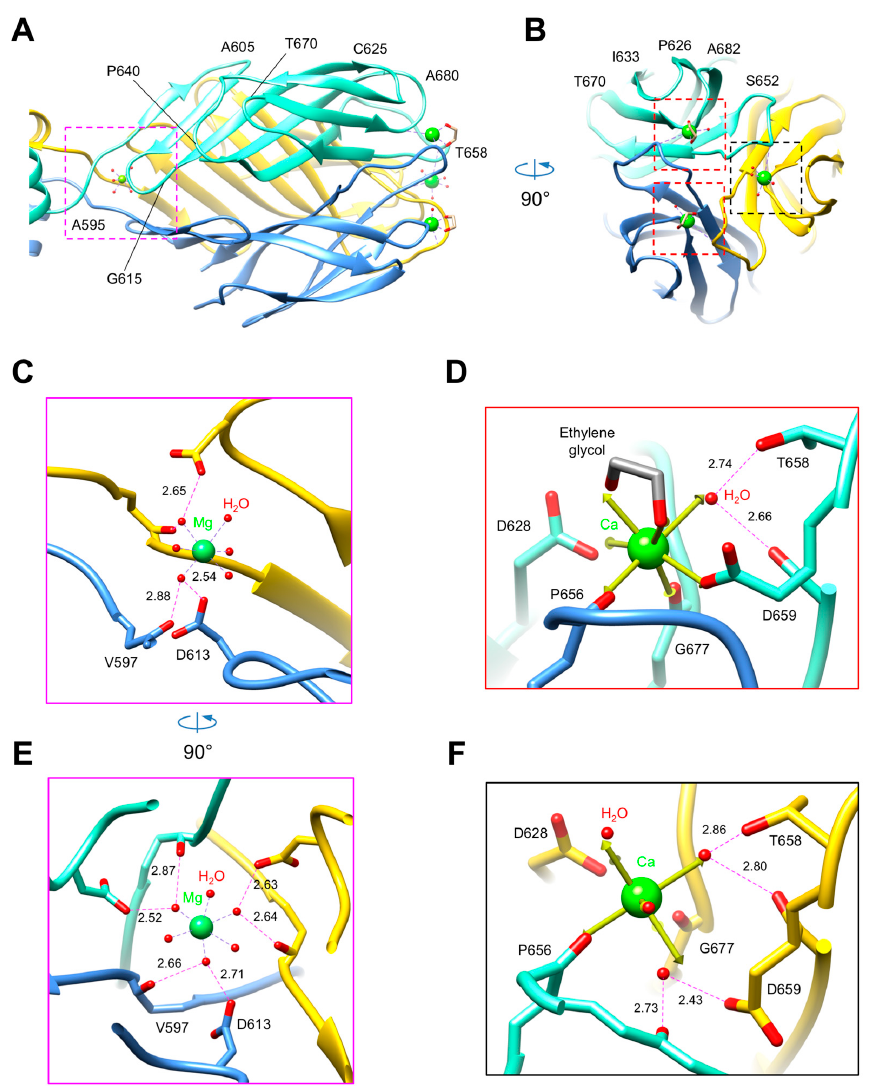
Figure 3. Structure of the R2 fiber C-terminal domain with bound metal ions and ligands. Side view ( A ) and C-to-N end-on view ( B ) of the R2 pyocin receptor binding domain. Cut-away side view ( C ) and C-to-N end-on view ( E ) of the magnesium site. ( D , F ) Structure of two different calcium ion binding sites. The three protein chains comprising the trimer are colored in gold, cornflower blue, and aquamarine. The dashed rectangles in the top panels mark the area of detail enlarged in the bottom panels. The magenta rectangle outlines the location of the magnesium ion. The red and black rectangles mark two different calcium-binding sites. The arrows in panel ( C ) represent the ideal coordination geometry for a calcium ion. The hydrogen and coordination bonds are showed as dashed lines. The distances of H-bonds between the outer and inner coordination shells are indicated in Å.